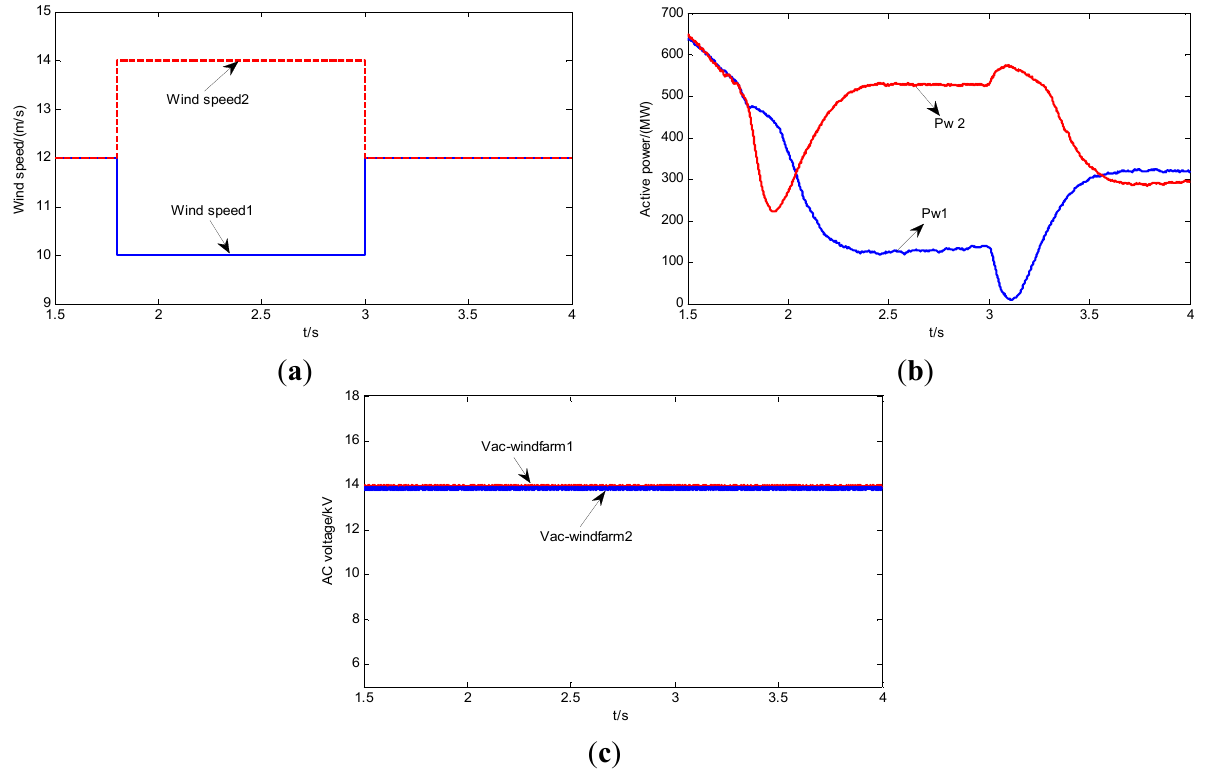
Figure 10. Simulation result with variation wind speed. ( a ) Wind speed; ( b ) AC voltage for different wind farm; ( c ) Active power on wind farm